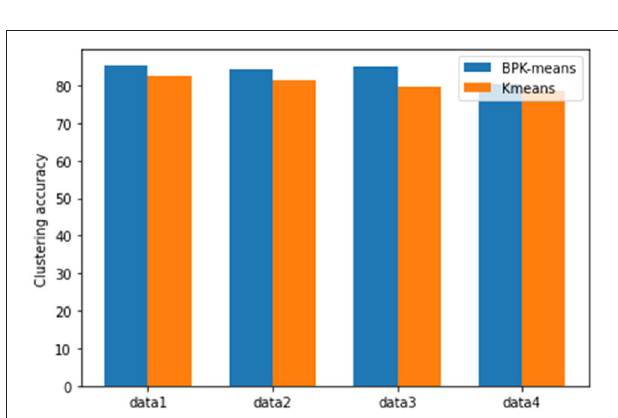
FIGURE 9 | View clustering effect